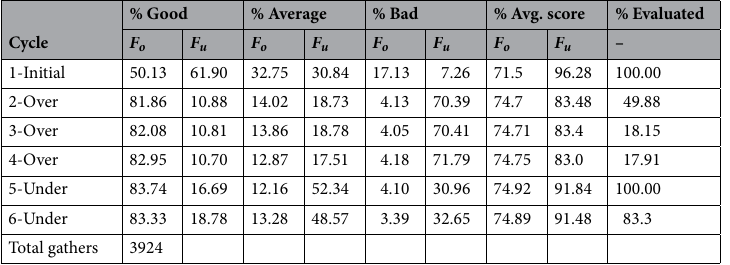
Table 3. Geocycles tabular results for noise suppression. We list the proportion as percentages of gathers classified as good, average, or bad for over and under attenuation criteria in each cycle. We also list the average scores for both criteria and the percentage of gathers evaluated in each cycle.